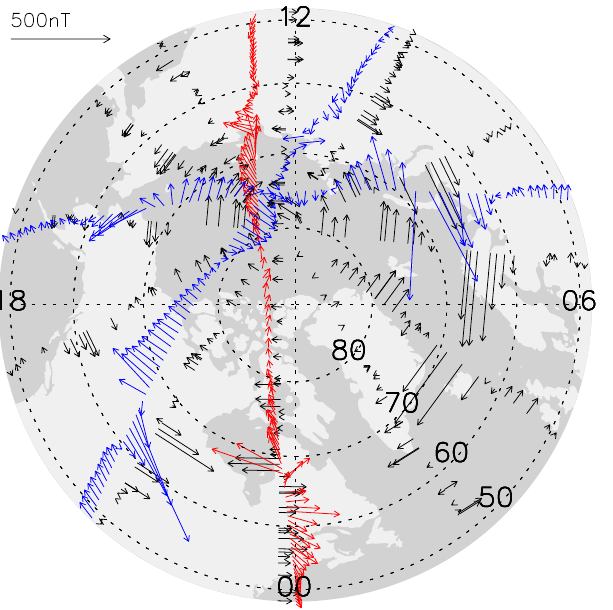
Fig. 5. Reconstructed full vector 4 b fit as a result of applying SCHA to all data in Fig. 4. Overlays of the DMSP and Oersted magnetic field observations are shown for comparison.